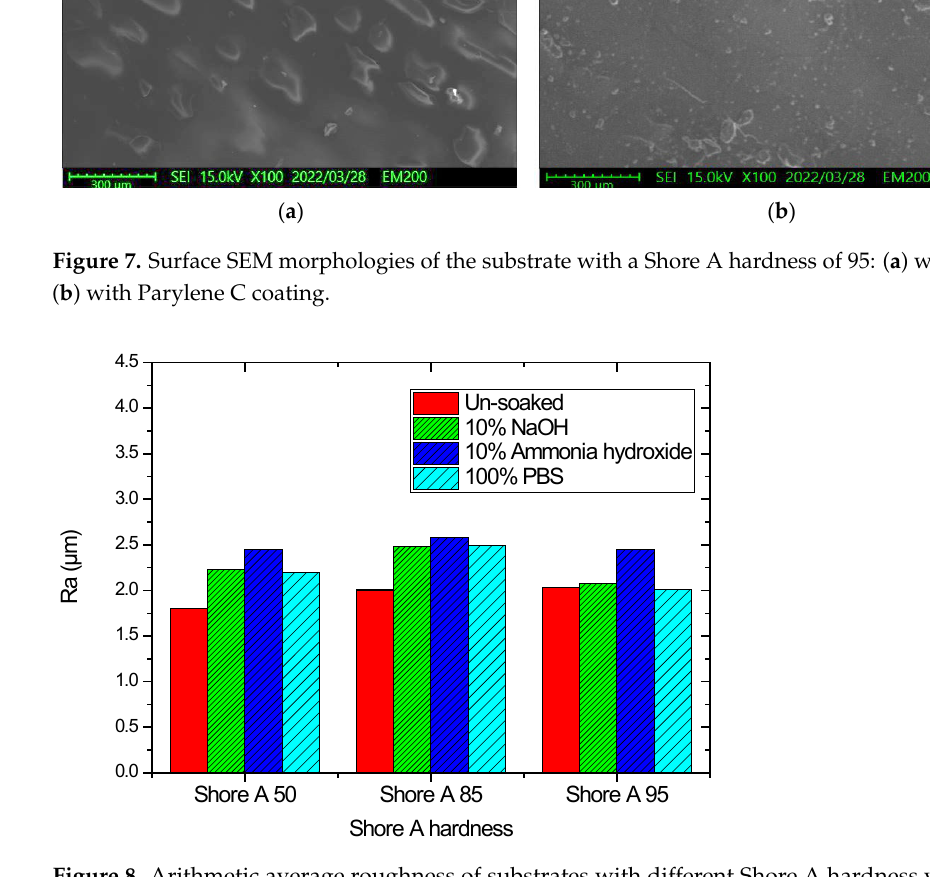
Figure 8. Arithmetic average roughness of substrates with different Shore A hardness values that were coated with Parylene C.